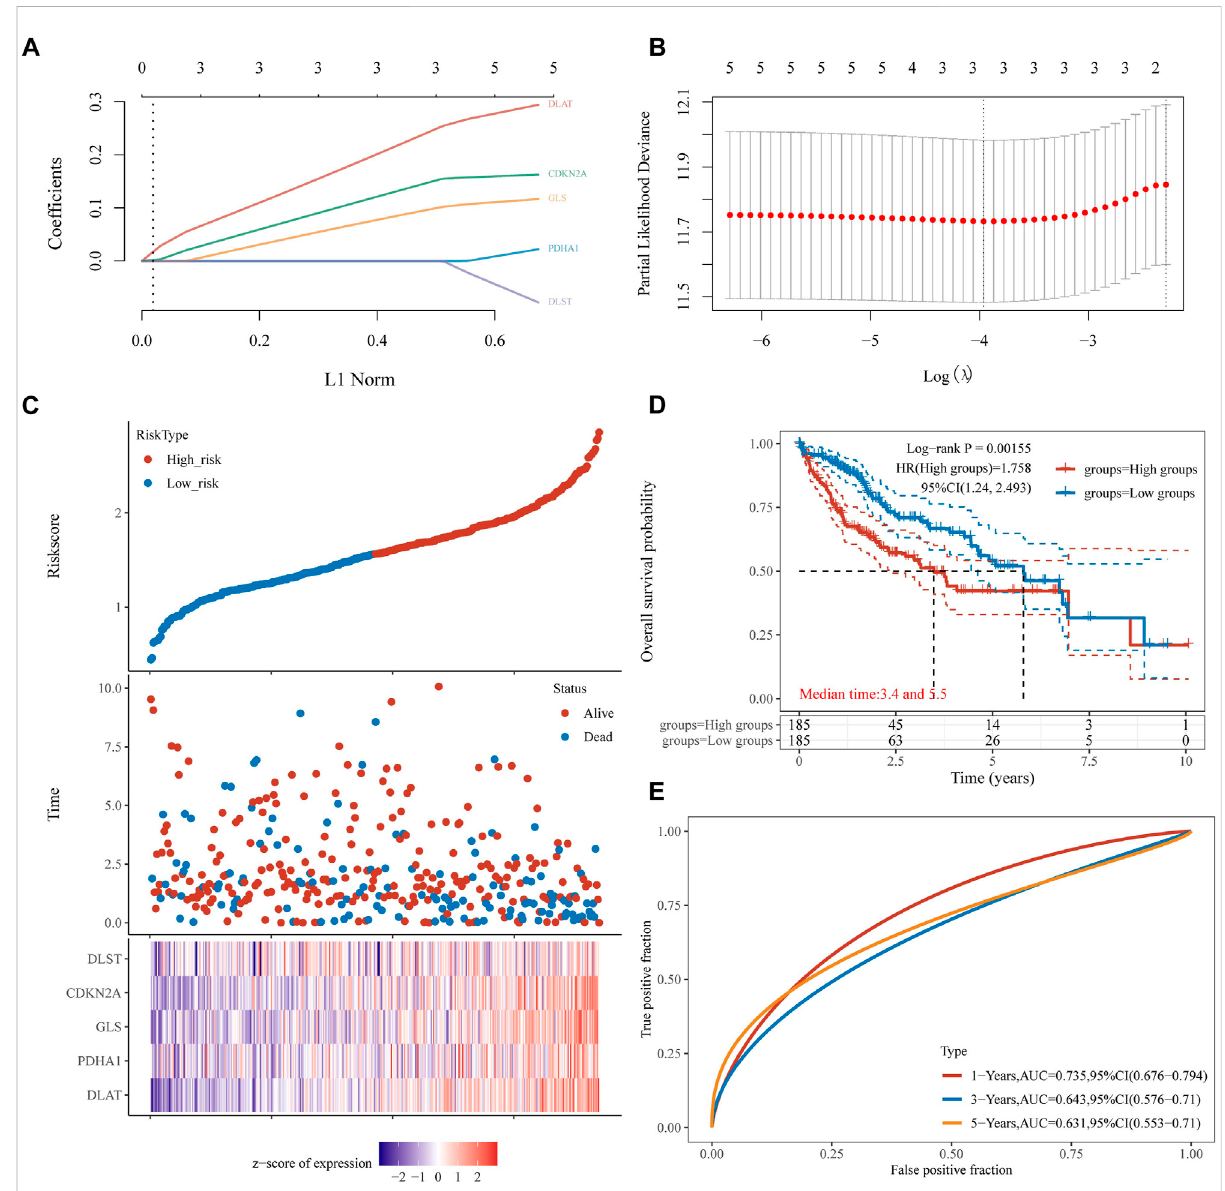
FIGURE 5 Construction of a prognostic CRGs model. (A) LASSO coef fi cient pro fi les of the fi ve CRGs. (B) Plots of the ten-fold cross-validation error rates. (C) Distributionofriskscore,survivalstatus,andtheexpressionof fi veprognosticCRGsinHCC. (D) , (E) OverallsurvivalcurvesforHCCpatientsinthe high-/low-risk group and the ROC curve for measuring the predictive